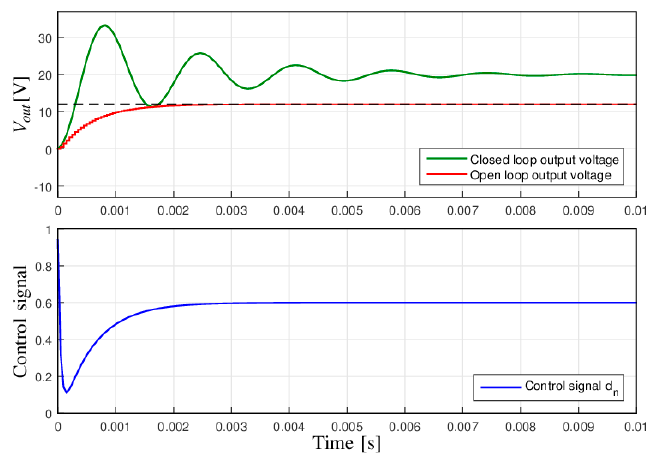
Figure 5. Open-loop step response (green), closed-loop step response (red) and the corresponding control variable (blue).